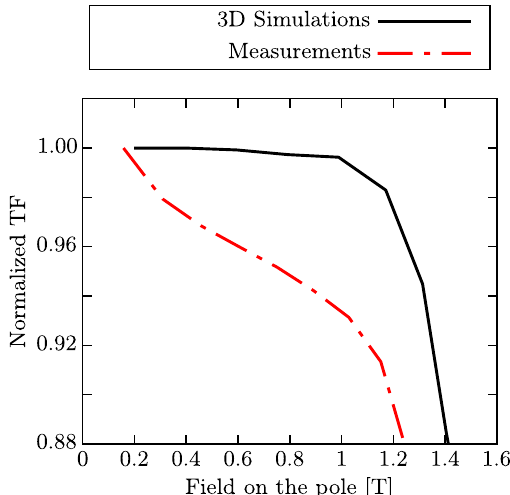
FIG. 9. Normalized center transfer function of ELENA diluted prototype ( λ ¼ 0 . 33 ) over iron field B ments from